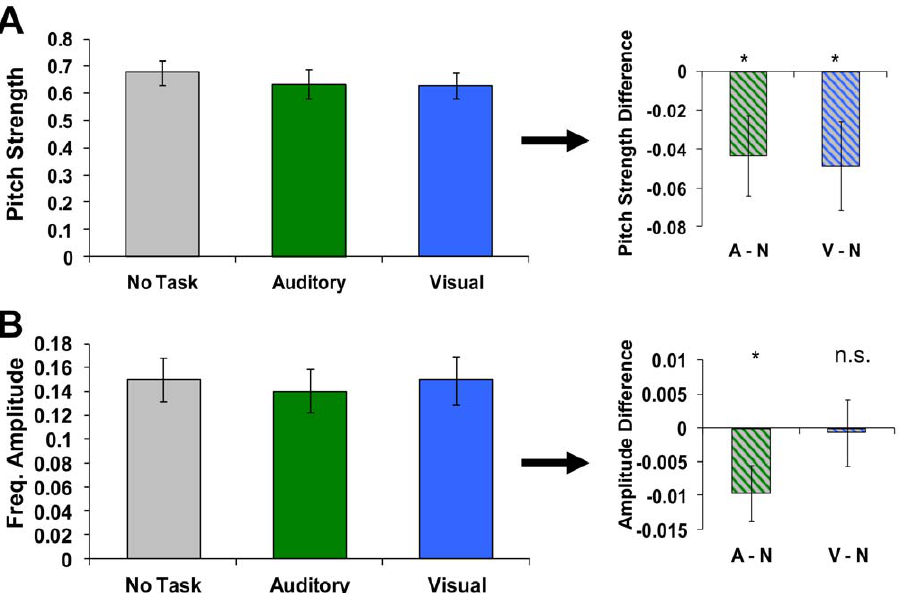
Figure 2. FFR metrics for each task type. Pitch strength significantly decreased for both visual and auditory tasks ( A ) relative to baseline (no task). In addition, average signal amplitude within the target frequency (220 Hz) decreased for auditory, but not visual tasks ( B ). Error bars represent standard error across subjects Asterisks on right denote significant (p , .05) differences. Note that only background stimuli not overlapping with the task and identical in all conditions were used in this analysis, suggesting a tonic suppression of background auditory signals that may be greater when also performing an auditory task.